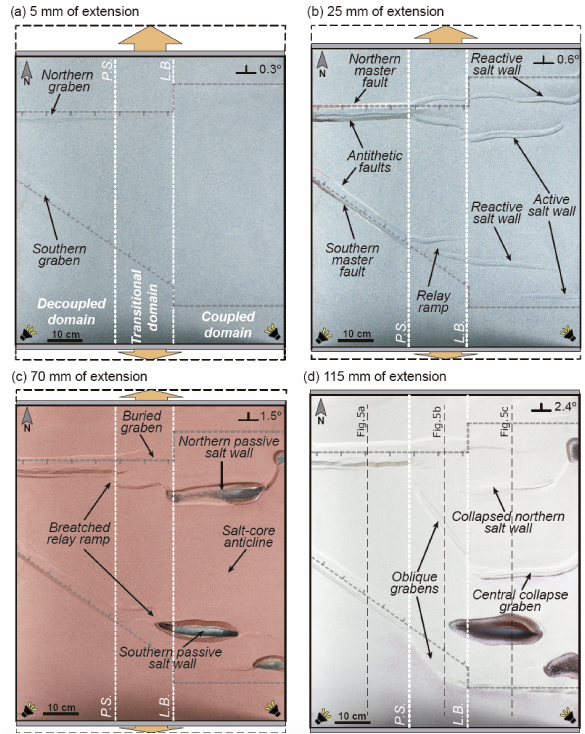
Figure 4. Overhead evolution of model 1 during extension. Illumi- nation comes from the left. The shadow areas are surface-breaching faults dipping to the right (north), and the illuminated ones are surface-breaching faults dipping to the left (south). The position of the basement rigid blocks is shown in grey dotted lines, and the polymer pinch-out (P.S.) and the limit of basement blocks (L.B.) are shown in white dotted lines. (a) Overhead view after 5mm of ex- tension. (b) Overhead view after 25mm of extension. (c) Overhead view after 70mm of extension. (d) Overhead view after 115mm of extension. The external dashed reference rectangle corresponds to the dimensions of the experiment after 115mm of extension (step d ) to show the movement of the two walls through time. The northern wall moved at a higher velocity than the southern one as represented by the arrows. Eight different layers (alternating red and white sand) were added during the